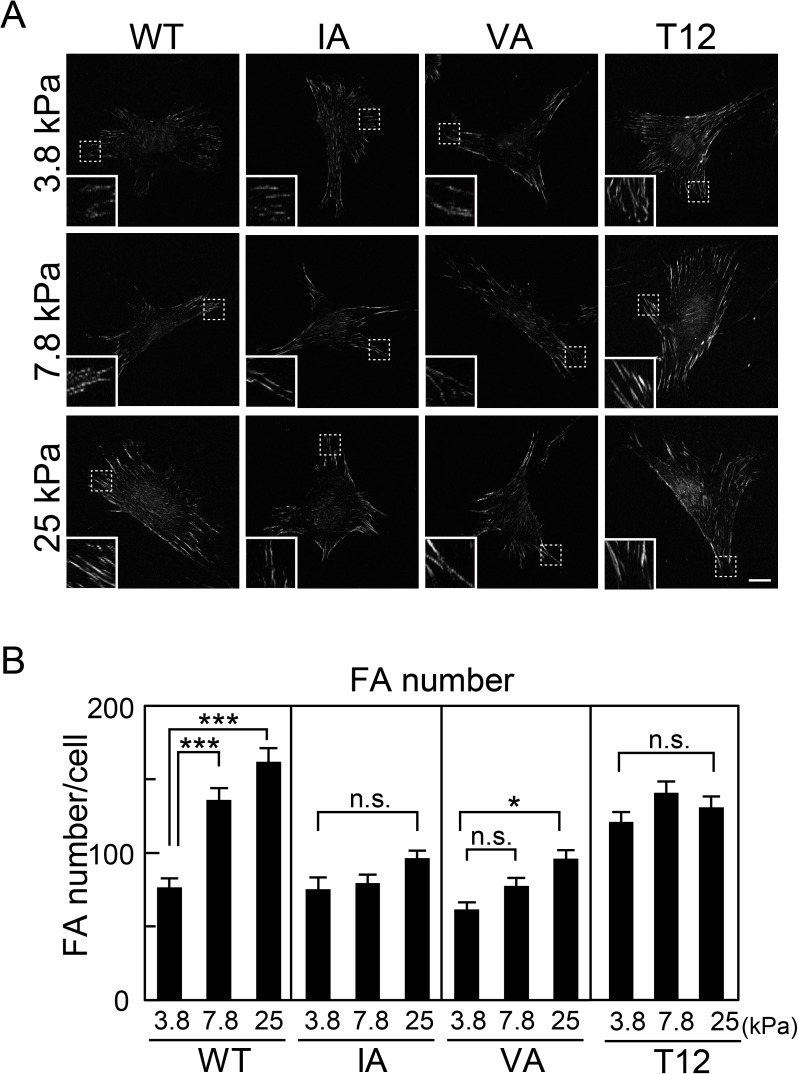
Visualization and quantification of CSB-resistant vinculin mutants.(A) GFP-vinculin-expressing cells cultured on polyacrylamide gels were treated with CSB, then fixed and visualized using GFP. The insets indicate higher-magnification images of the areas indicated with dashed boxes. Scale bar: 20 μm. Fifty individual cells from three separate experiments were photographed for each condition. (B) FA numbers were quantified from (A) using ImageJ. The values represent the means ± S.E.M. One-way ANOVA, Scheffe’s test (n = 50; *P<0.05, ***P<0.001 compared with 3.8 kPa gel; n.s., non-significant).